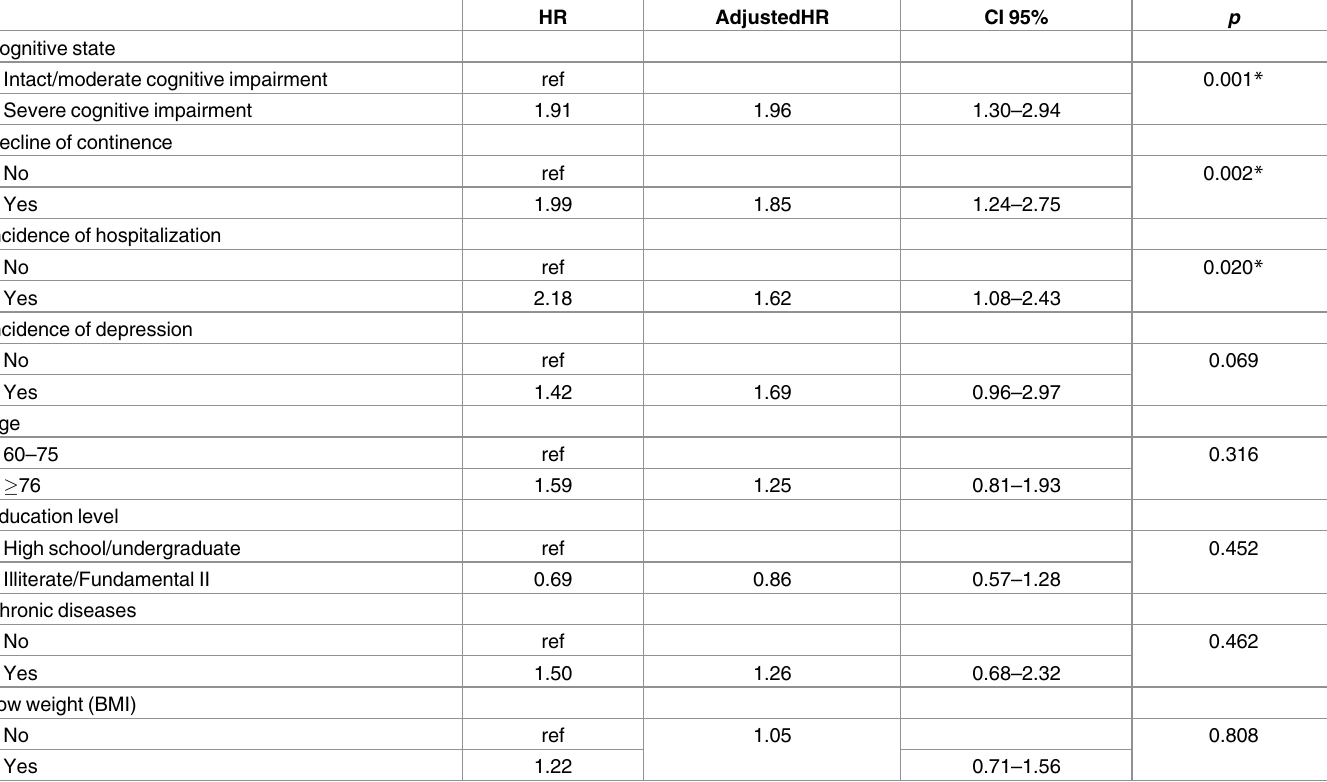
Table 5. Final model for functional decline in institutionalized older adults (n = 280) in Natal/RN, according to Cox’s model. Natal/RN, 2016. HR AdjustedHR CI 95%